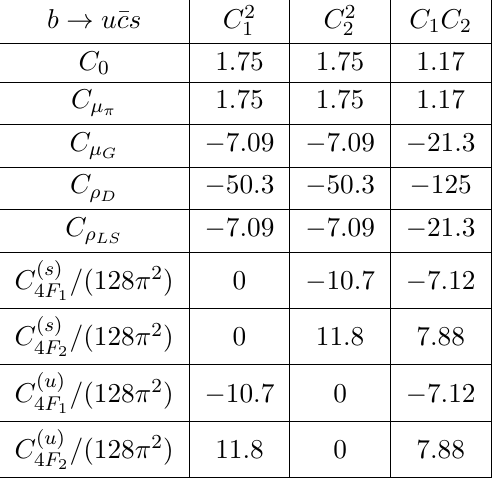
Table 3 . Numerical values for the coefficients of b → u ¯ cs . and C ( µ ) = 0 . 274 at µ = 4 . 0 GeV given in ref. [51]. We 2 b b